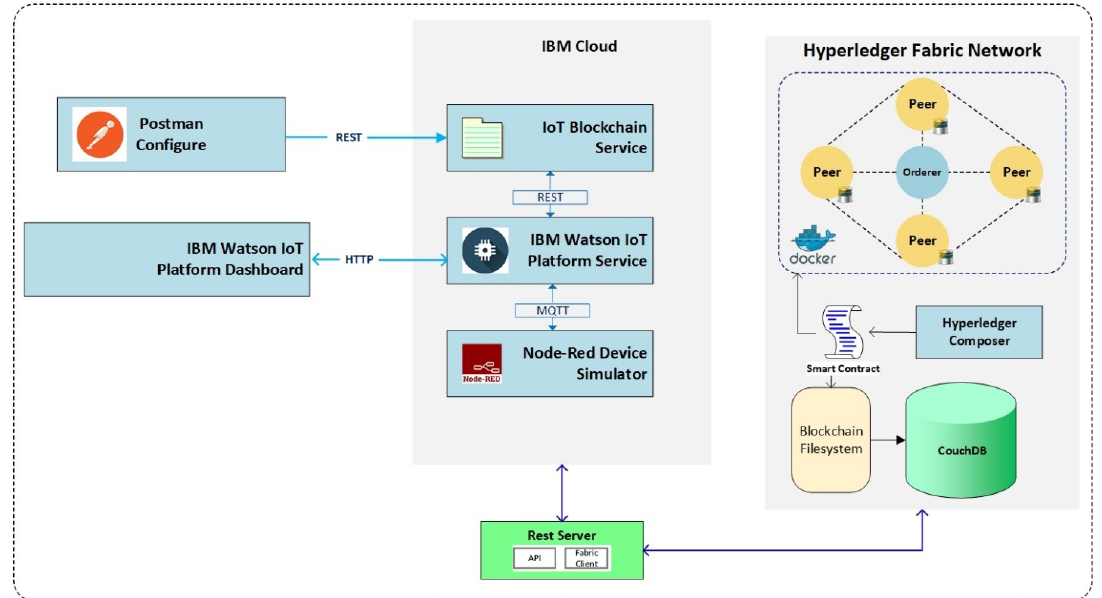
Figure 10. The implementation structure of the blockchain IoT